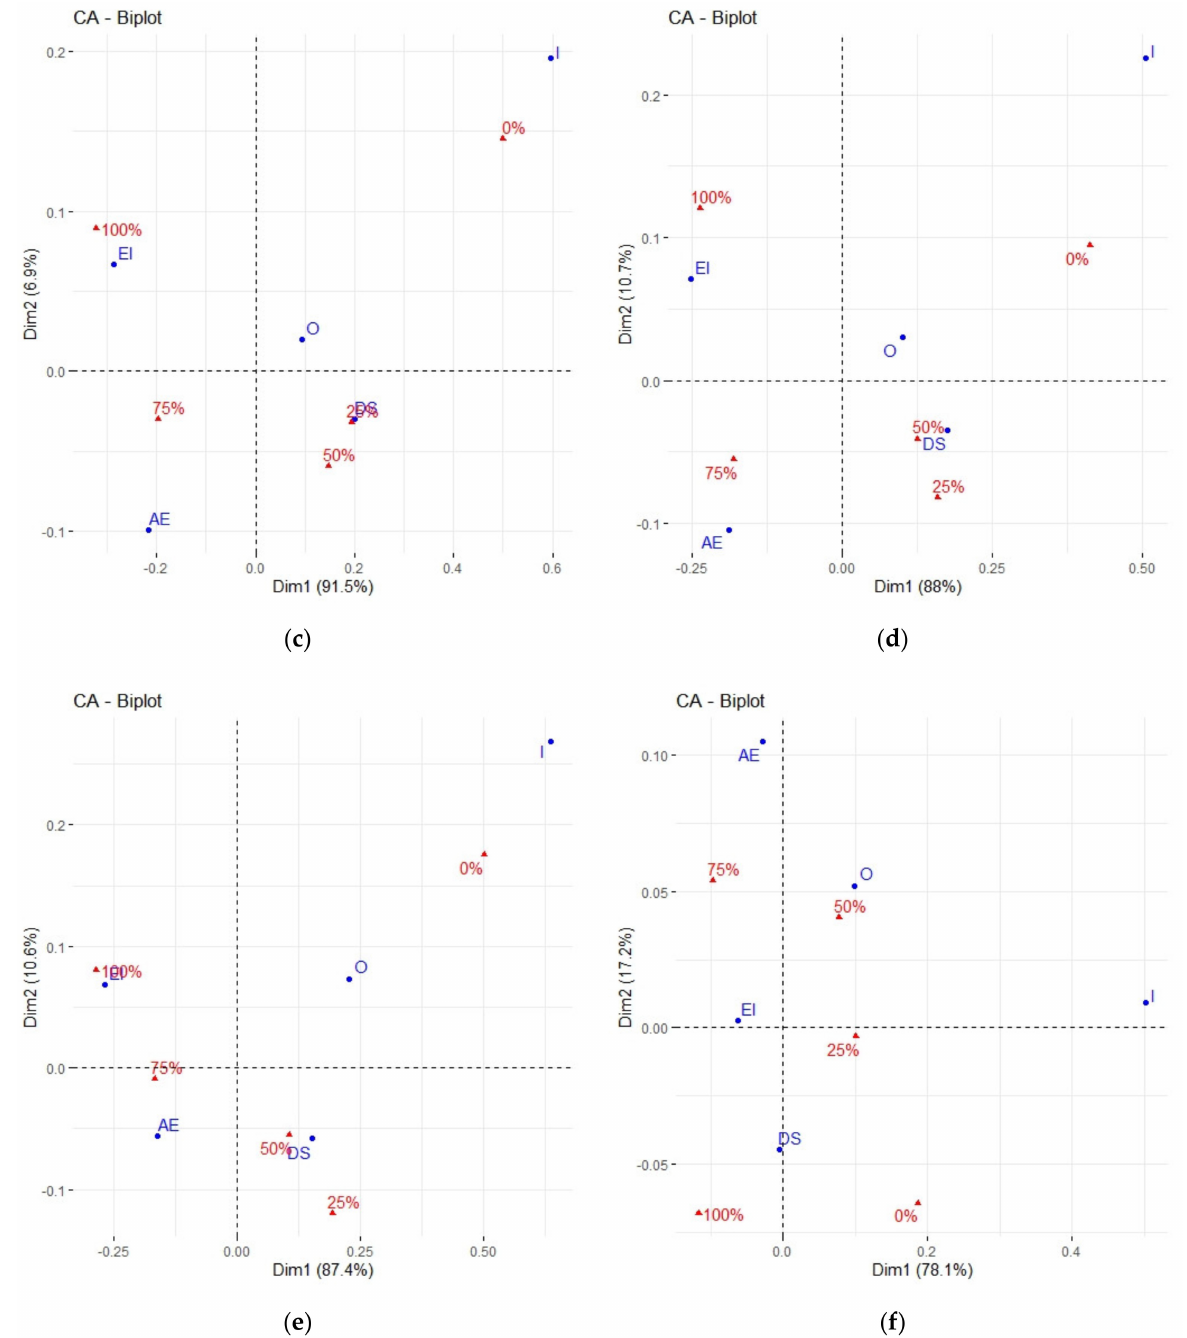
Figure 1. Correspondence maps showing the links between the 5 types of energy consumers and their declared degree of usefulness of selected types of incentives: ( a ) professional audit/analysis of household’s energy consumption; ( b ) use of a dedicated application or other IT tool (e.g., a chatbot); ( c ) social campaigns on energy (advertising spots, billboards); ( d ) obtaining repayable funding for investments related to energy saving or renewable energy sources (RES); ( e ) keeping up with the green trend; ( f ) increased energy